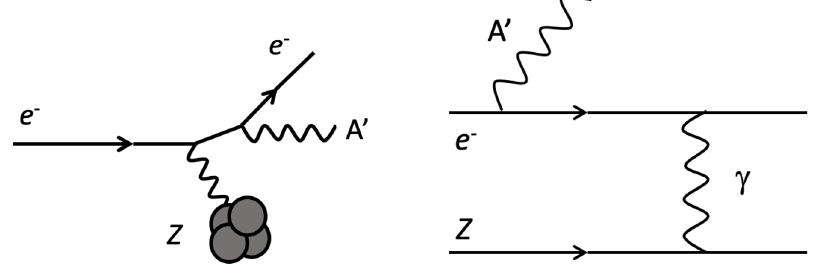
Figure 5 . Dark Photon production via the “darkstrahlung”